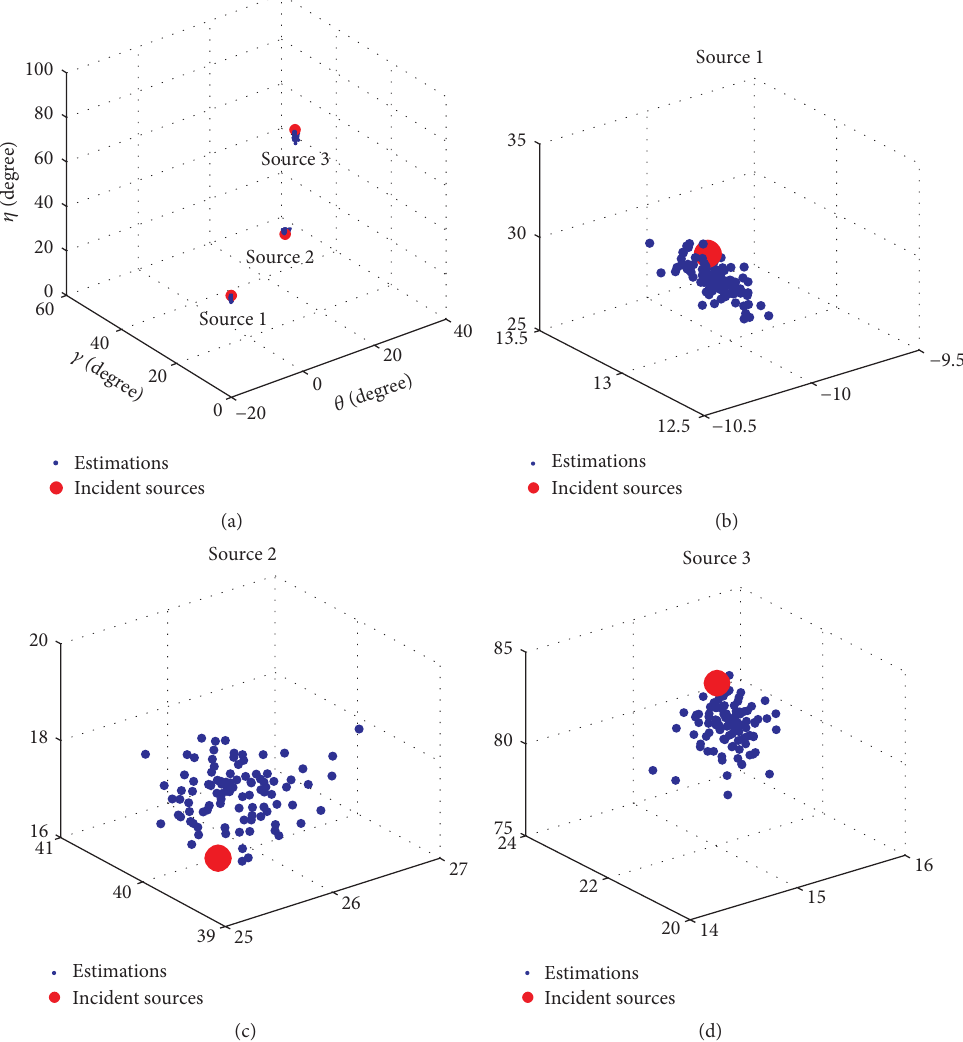
Figure 4: Scatter plot of the coherent sources. (a) Global figure; (b), (c), and (d) display the enlarged local scatter plots for coherent sources 1, 2, and 3,